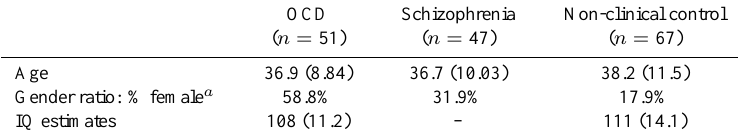
Table 1 Characteristics of the groups of participants: mean age and standard deviations, gender